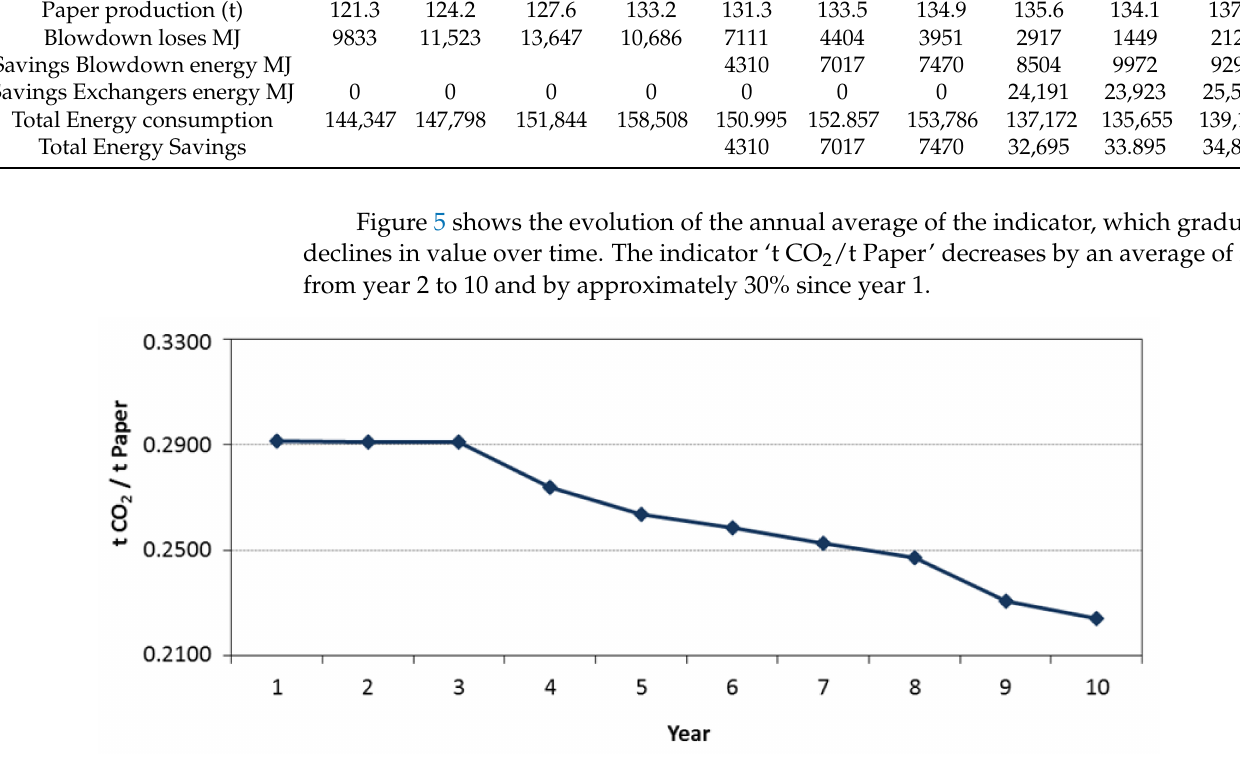
Figure 5. Evolution of the indicator—“t CO 2 /t Paper” over 10